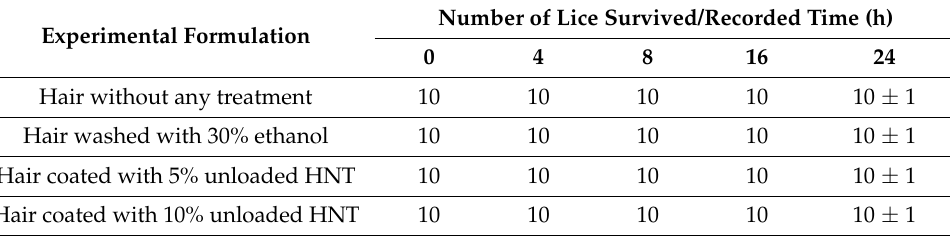
Table 3. Negative control performance of 30% alcohol and halloysites (HNT) on D. caprae lice. Experimental